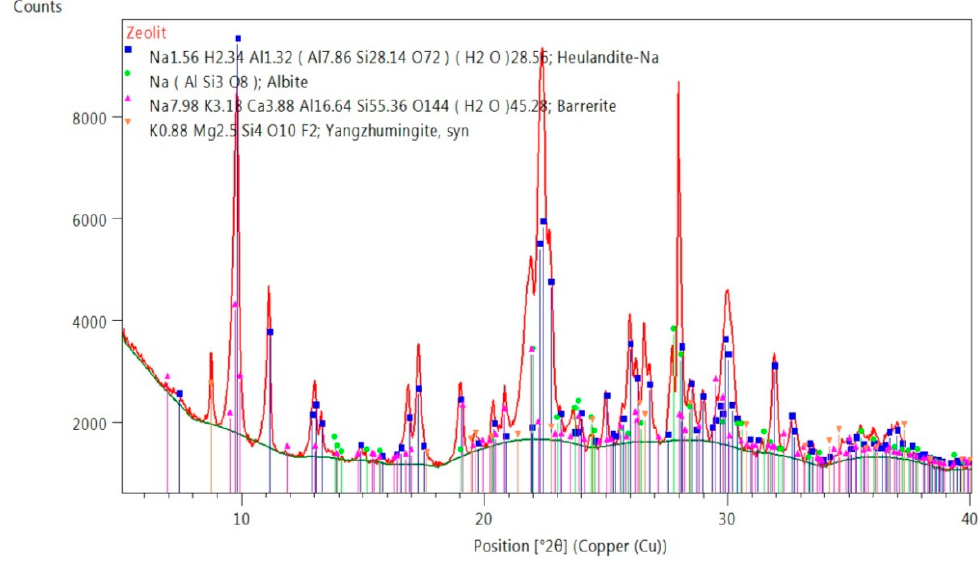
Figure 4. Phase composition of zeolite ZeoBau 50 [71].